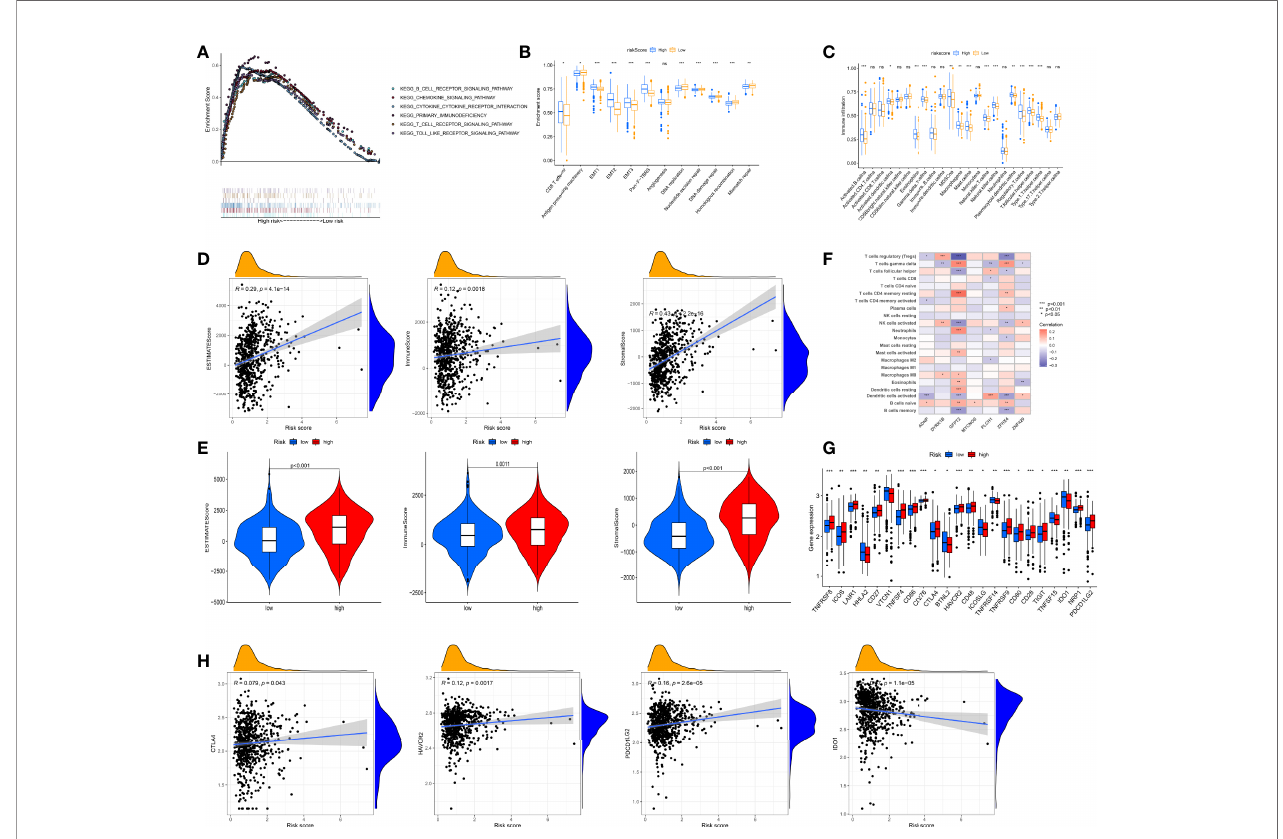
FIGURE 6 | Evaluation of the tumor immune microenvironment (TME) and checkpoints between the two groups. (A) Enrichment plots showing B-cell receptor signaling pathway, chemokine signaling pathway, cytokine – cytokine receptor interaction, T-cell receptor signaling pathway, primary immunode fi ciency, and Toll-like receptor signaling pathway were enriched in the high RMW score subgroup. (B) Differences in interstitial activation pathways of two groups. (C) 23 TME cells ’ in fi ltration abundance of two RMW score subgroups. (D, E) Correlations between two groups and TME score. (F) Correlations between the abundance of immune cells and seven genes in model. (G) Expression of 23 immune-related genes in two groups. (H) Expression levels of CTLA4, HAVCR2, PDCD1LG2, and IDO1 in two groups. Adjusted p-values were shown as ns, not signi fi cant; *p < 0.05; **p < 0.01; ***p <